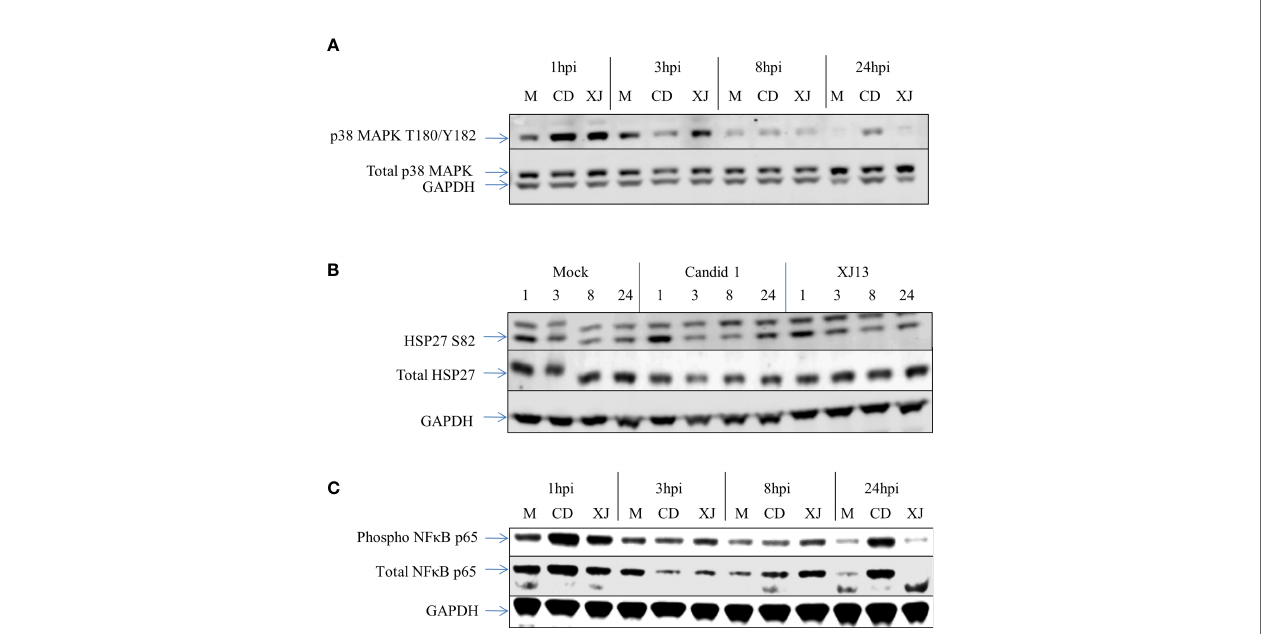
FIGURE 1 | Western blot data for p38 MAPK, HSP-27, and NF k B from RPPA samples. HSAEC cells were infected with an MOI of 10 for each virus, or mock infected. At 1, 3, 8, or 24 h post infection the cells were lysed and the virus was inactivated. The Western blot was performed with one sample per virus or mock per timepoint. The RPPA data was performed and analyzed utilizing technical duplicates and experimental triplicates, for a total of 6 samples per timepoint per virus or mock. (A) A Western blot representative of three separate experiments for p38 MAPK. (B) A Western blot representative of three separate experiments for HSP-27. (C) A Western blot representative of three separate experiments for NF k